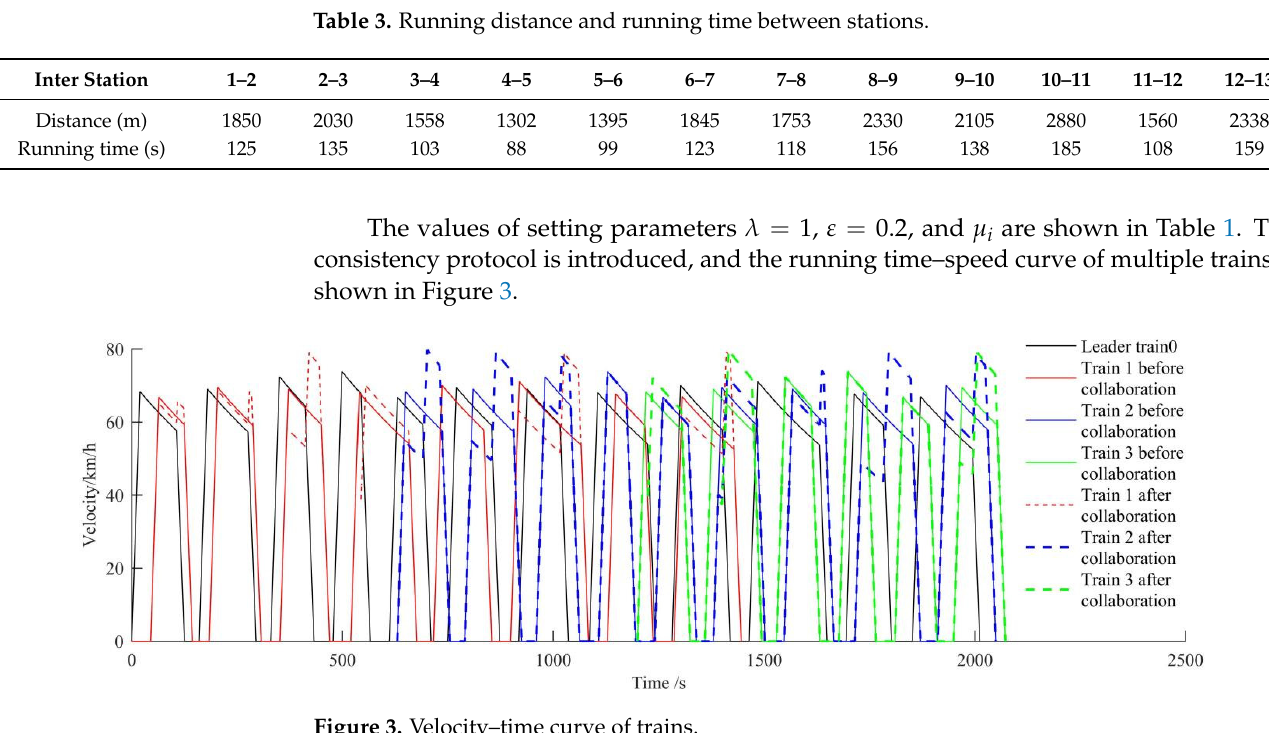
Figure 3. Velocity–time curve of trains.